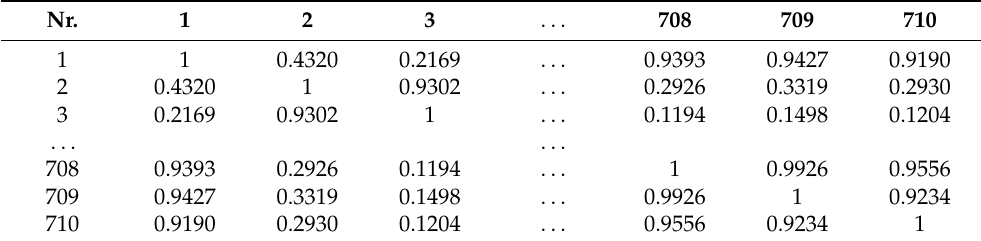
Table 2. Partial grid illustration of the final similarity matrix (710*710).